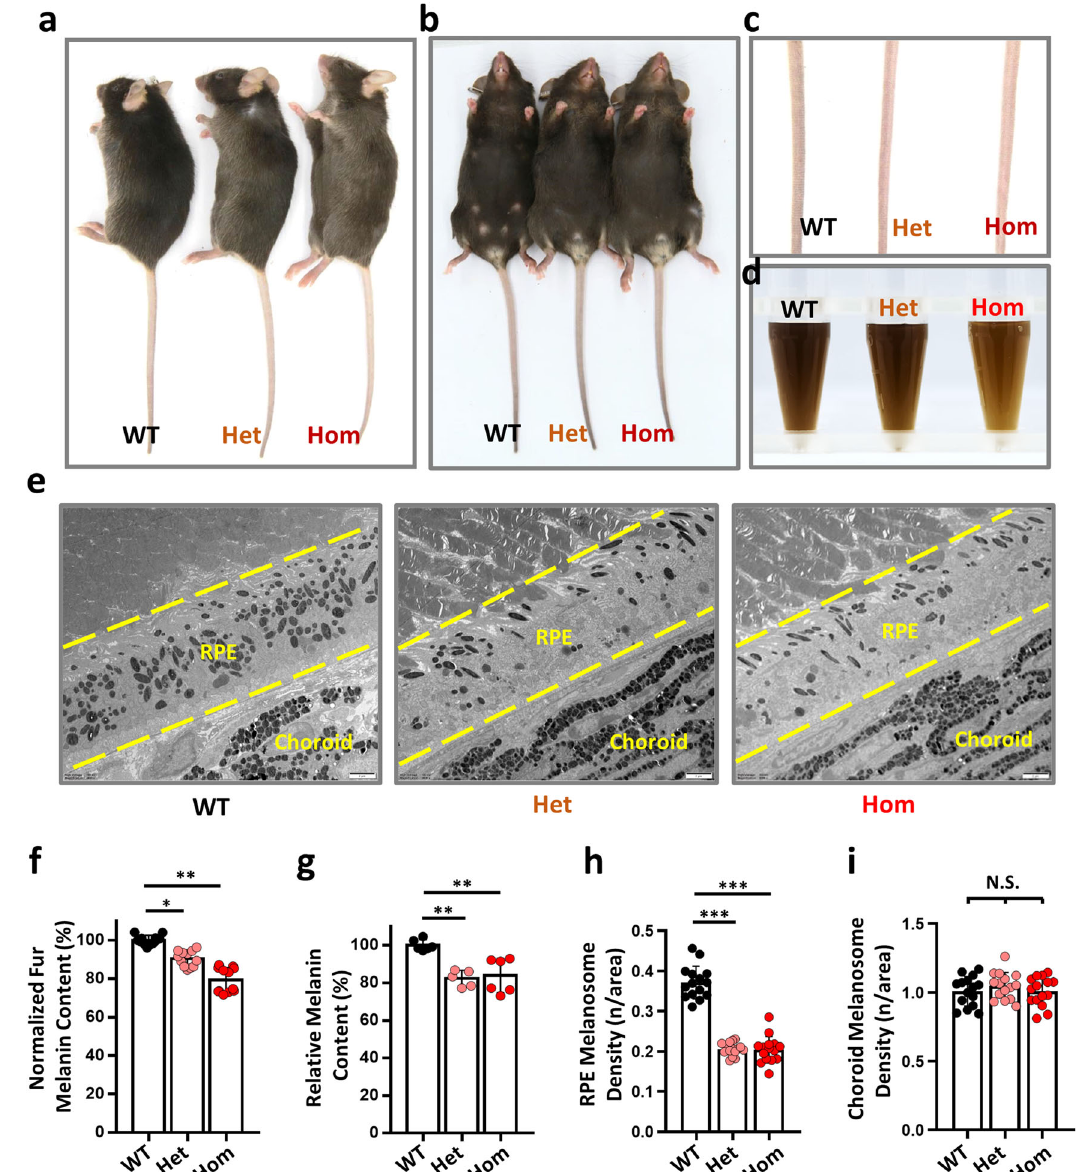
Fig. 6 | Tpcn2 R194C knock-in mice exhibit hypopigmentation. a – c R210C in human TPC2 corresponds to R194C in mouse TPC2 ortholog. The R194C KI mutant was successfully generated by genome editing with a single guide RNA targeting exon 6 of the mouse Tpcn2 gene. After three generations of hetero- zygous mating since F1, reduced pigmentation in fur and tails were observed in the heterozygous (Het) and homozygous (Hom) KI mice on the C57/B6J back- ground(WT,wild-type). d Sideviewoffurlysatesintubes.Sameamounts(30mg) of ventral fur from WT, Het and Hom were collected and lysed with a lysis buffer. e Transmission electron microscopic pictures of retina dissected from WT, Het and Hom mice. Scale bar, 2 µ m. This assay was repeated three